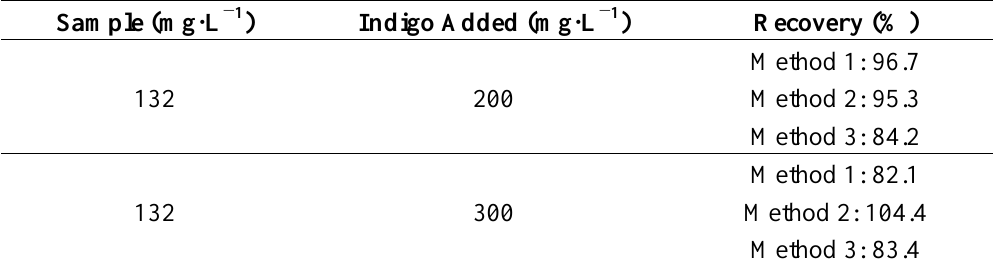
Table 3. Accuracy obtained for each level of concentration